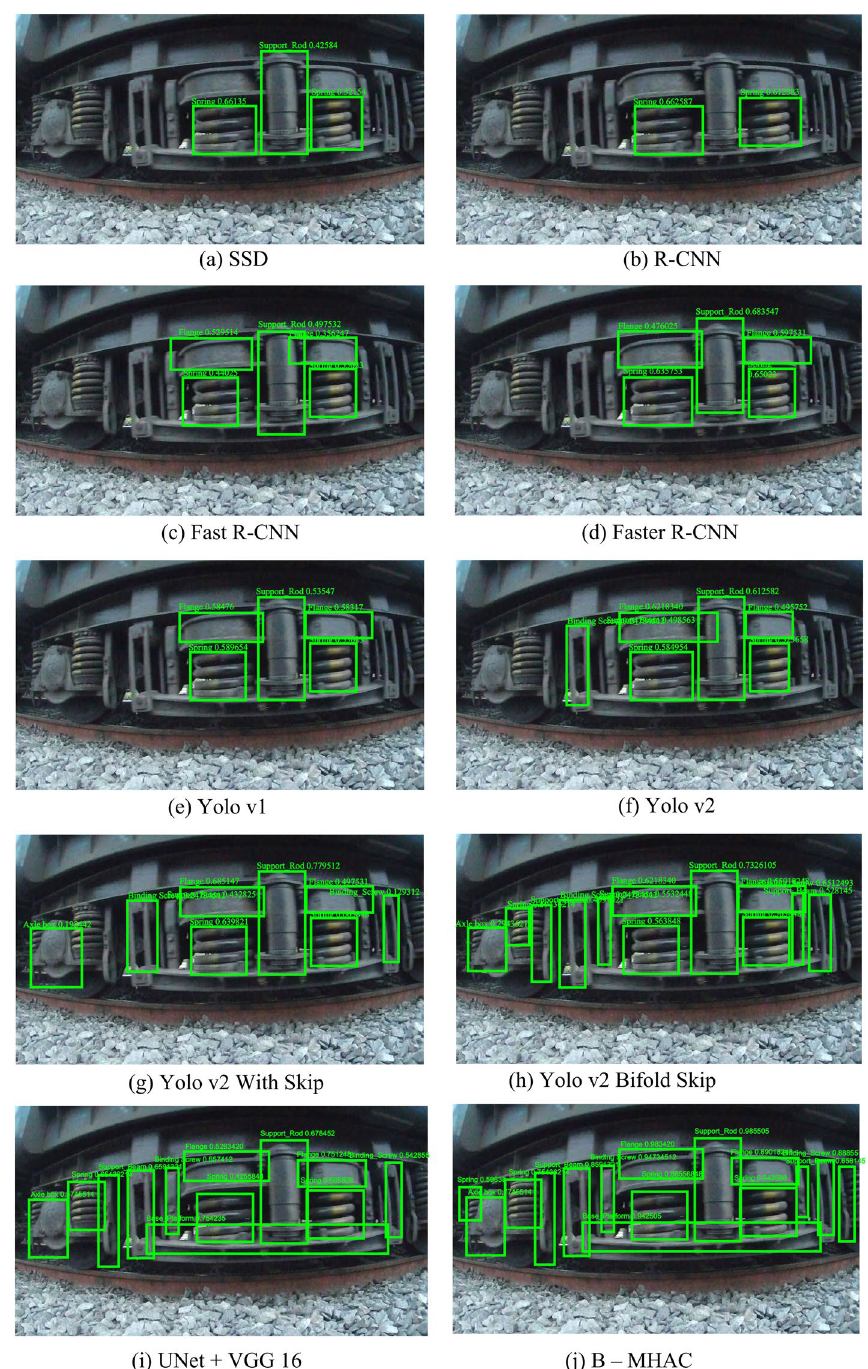
Fig. 11 Comparison of approaches for bogie part identification with the proposed B-MHAC (Zoom for better visibility). a B-7: spring defects identification in frame 5596. a SSD. b R-CNN. c Fast R-CNN. d faster R-CNN. e Yolo v2 with skip. h Yolo v2 bifold skip. i UNe VGG 16. j +